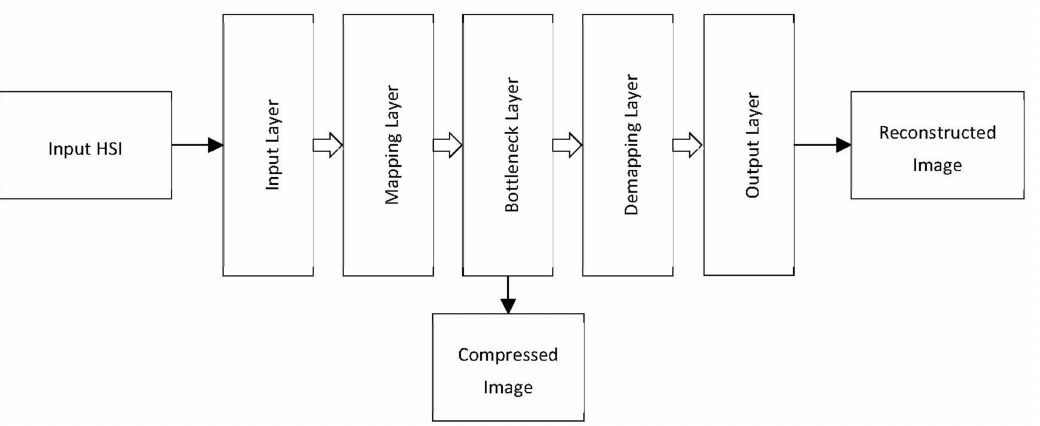
Figure 16. Conceptual framework of hyperspectral image compression and restoration using the learning-based class of